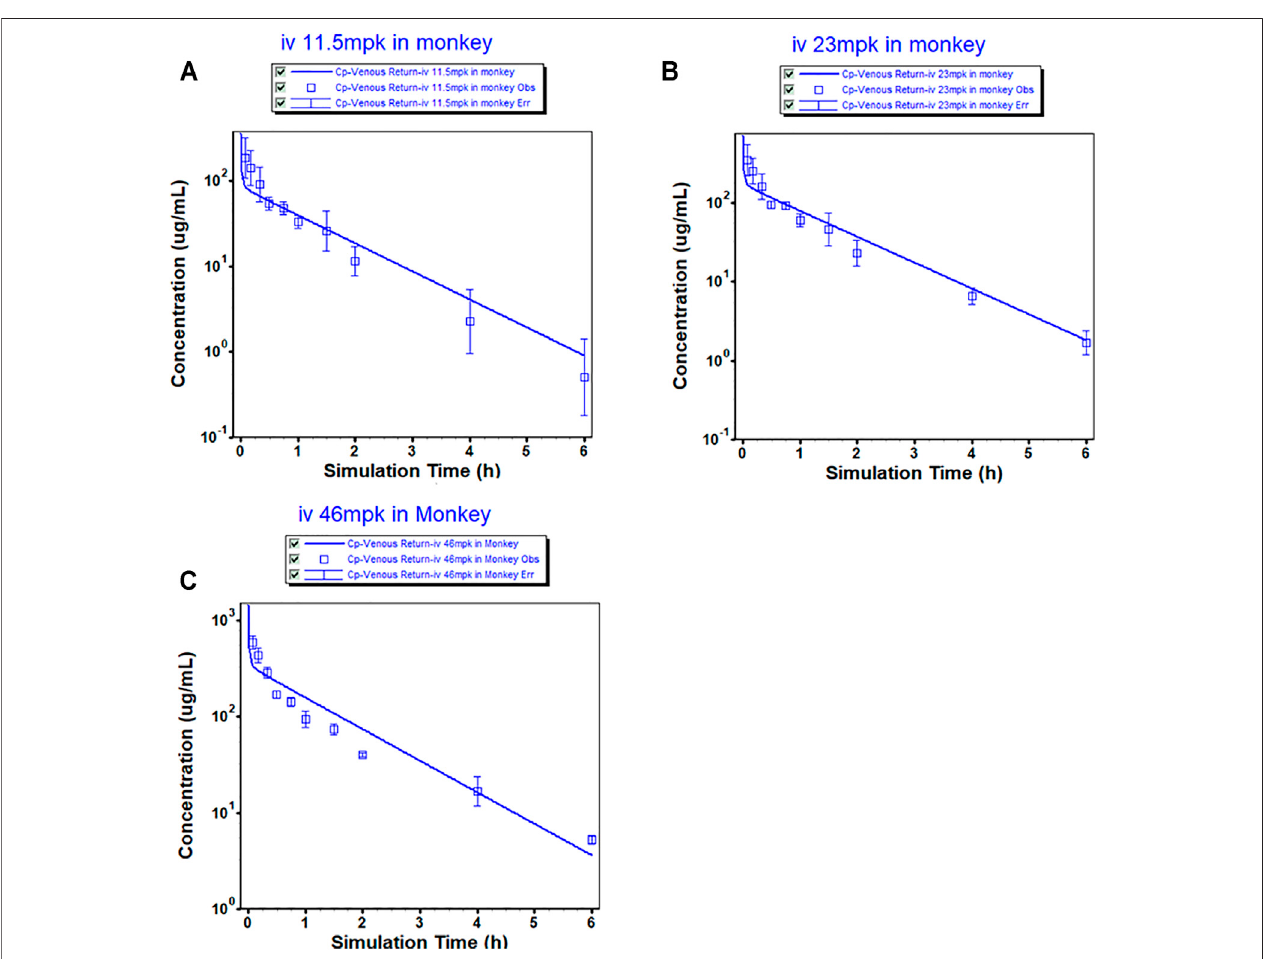
FIGURE 1 | Observed (mean ± SD) and physiologically based pharmacokinetic (PBPK) model-simulated plasma concentration-time pro fi le in monkeys after intravenous injection of MK-ASODN nanoliposomes at doses of 11.5, 23 and 46 mg kg − 1 ( n (cid:1) 3).